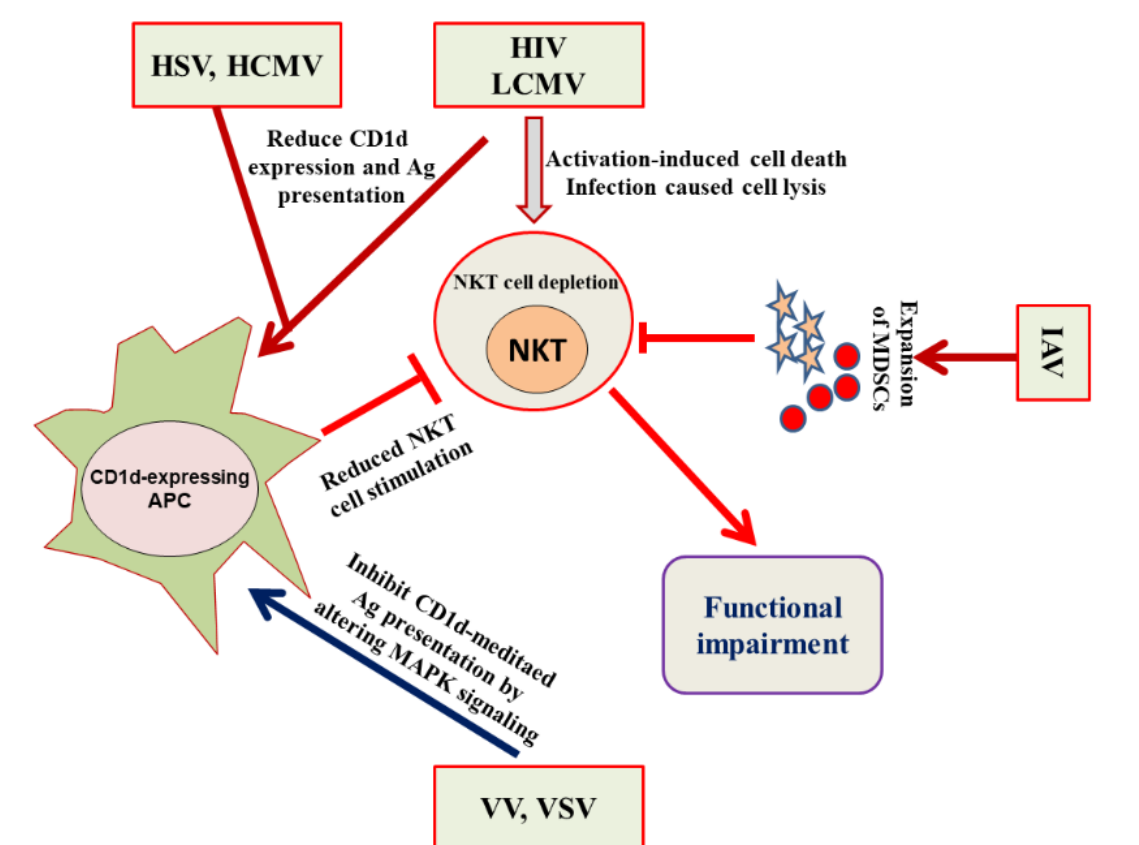
Figure 3. HIV, LCMV, HSV, HCMV, VV, VSV and IAV adopt different strategies to evade the NKT cell-mediated immune responses. HSV, HCMV, HIV and LCMV reduce the expression of CD1d on APCs. HIV and LCMV induce the activation- induced cell death in NKT cells. IAV induces the expansion of MDSCs that cause the impairment of NKT cell functioning. VV and VSV impede the NKT cell stimulation by inhibiting the CD1d-mediated antigen presentation .